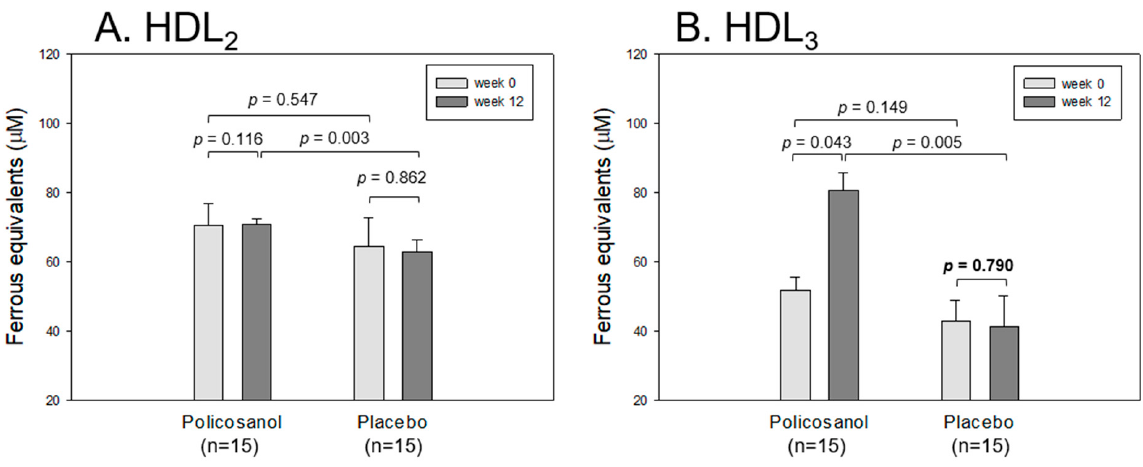
Figure 7. Comparison of the ferric ion reduction ability (FRA) of HDL 2 ( A ) and HDL 3 ( B ) in the